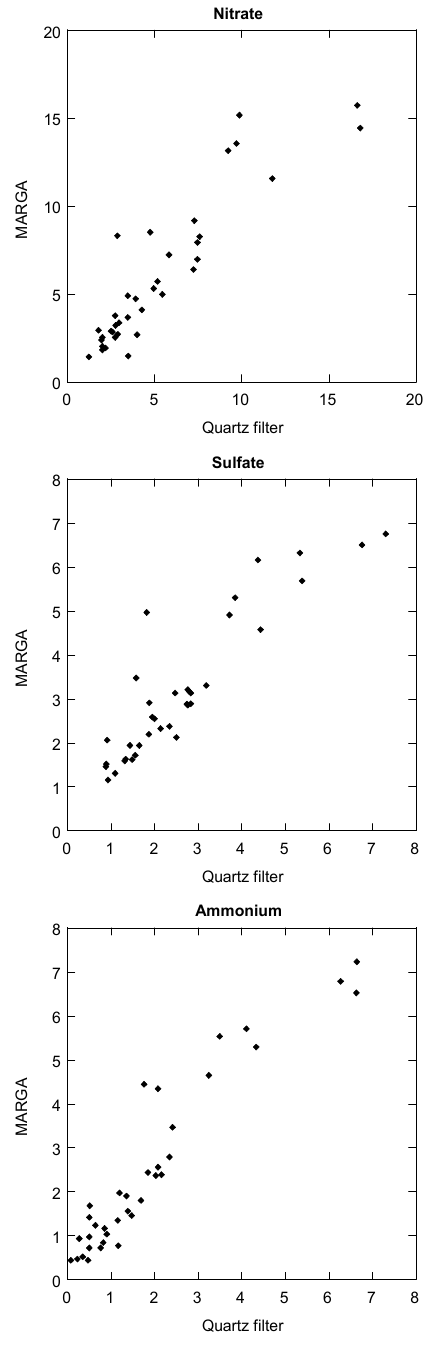
Fig. 1. Comparison between daily average concentrations (µgm − 3 ) of nitrate, sulfate and ammonium as obtained by the MARGA and co-located quartz filter samples at Figure 1. Comparison between daily average concentrations (µg/m 3 ) of nitrate, sulfate and 3 ammonium as obtained by the MARGA and co-located quartz filter samples at Cabauw. 4